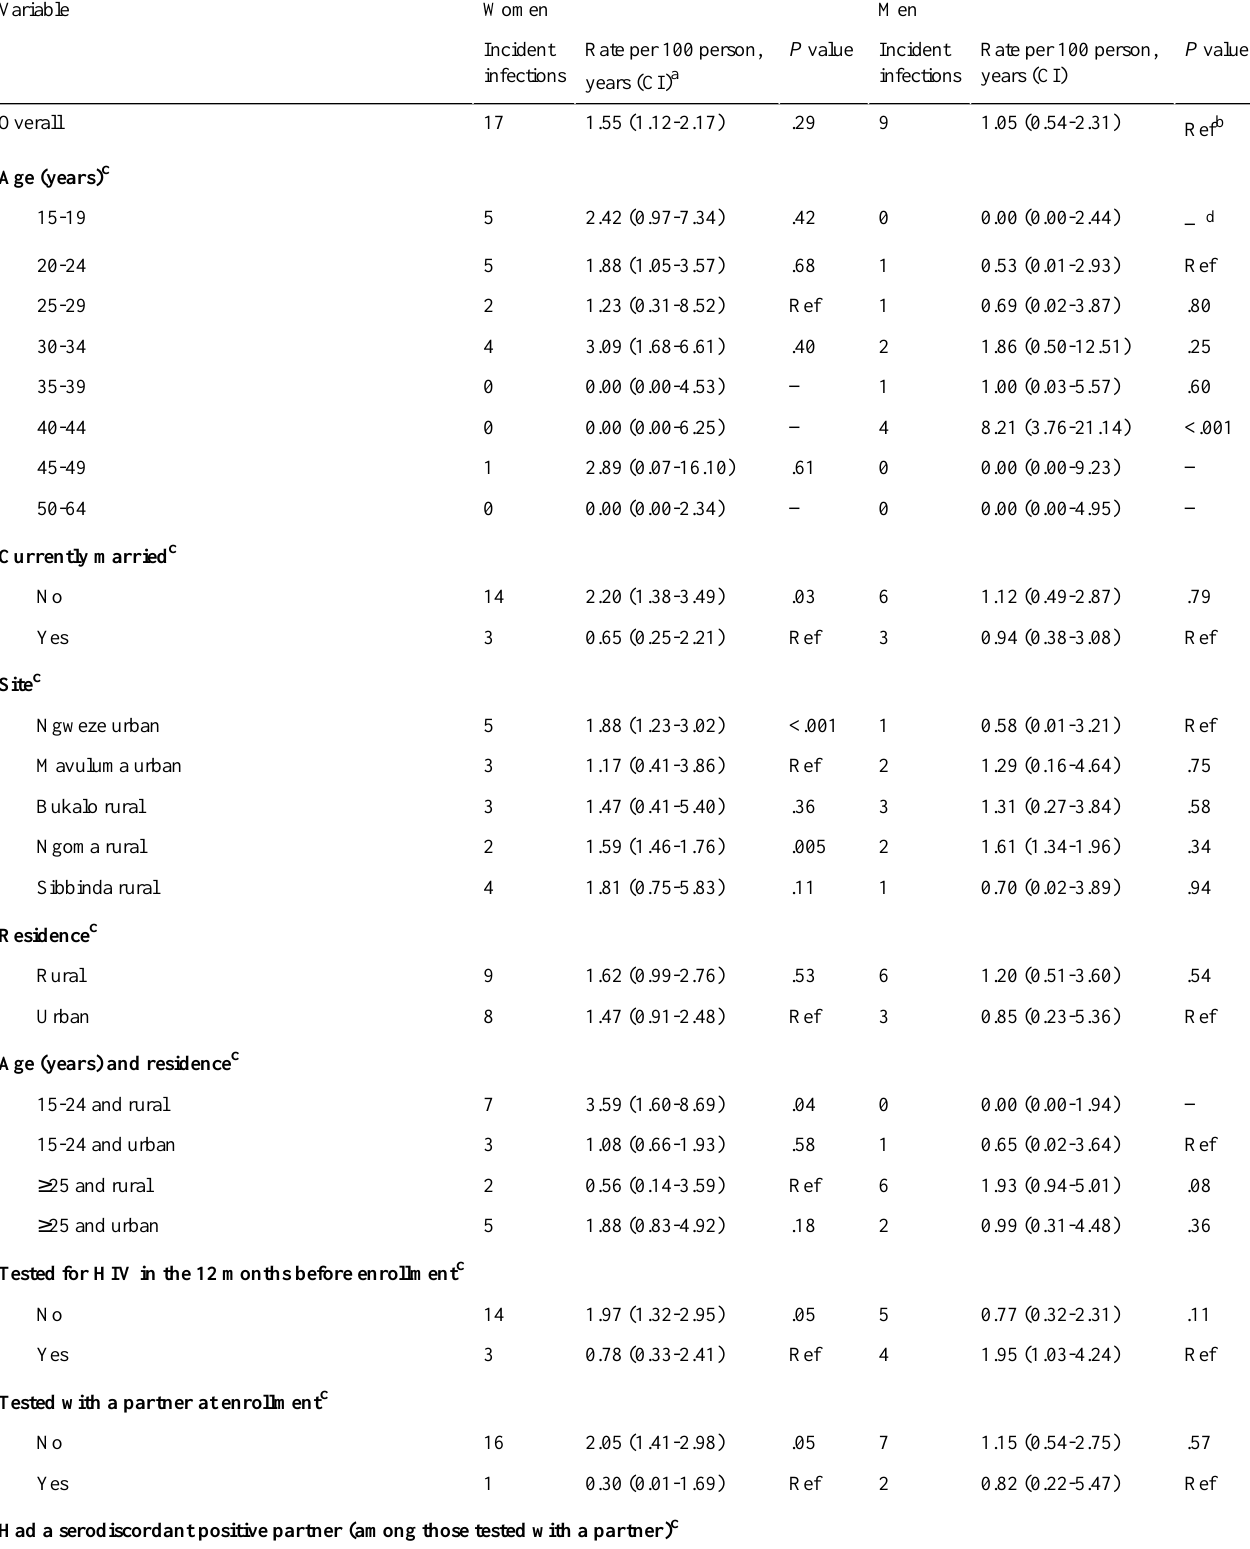
Table 2. HIV incidence per 100 person-years by sex and demographic and behavioral characteristics—household cohort study of adults aged ≥ 15 years in the Zambezi region of Namibia, 2014 to 2016